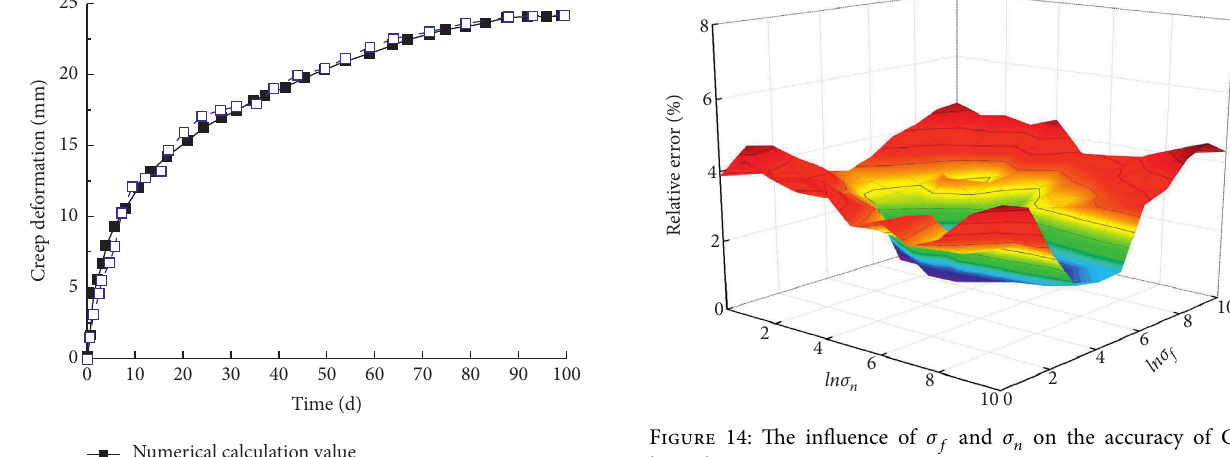
f and σ n on the accuracy of GP